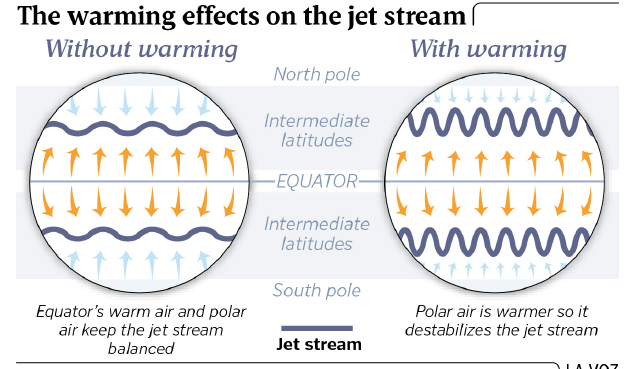
Figure 4. This figure explains how climate change is causing the jet stream to weaken in the Northern Hemisphere, prompting it to more frequently travel from north to south and from south to north instead of moving from west to east, thereby often generating situations of extreme weather, such as heat and cold waves, at midlatitudes.